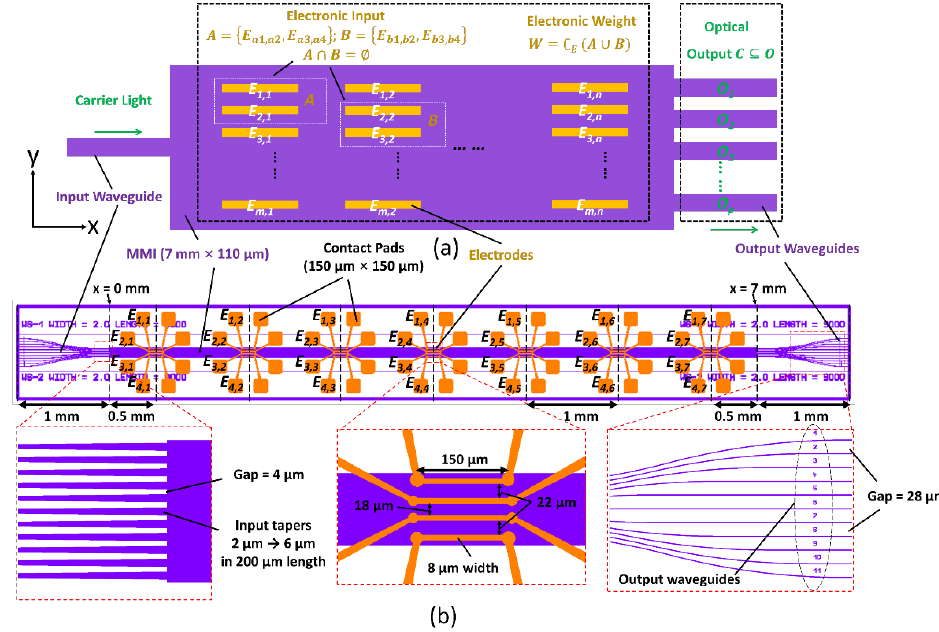
Figure 1. ( a ) Architecture of the function programmable waveguide engine (FPWE) to be used as a two-bit logic gate. The optical path contains an input waveguide, a multimode waveguide, and a series of output waveguides. Both the electronic inputs A , B , and the weights, can be chosen from the electrode network E . The logic outputs C are converted to optical intensity variations to be collected from two waveguide ports in O . ( b ) Actual chip design showing the layout of the electrode network. The redundant waveguide ports are reserved for further development. The insets are the detailed designs of the input tapers, electrodes, and the output waveguides.